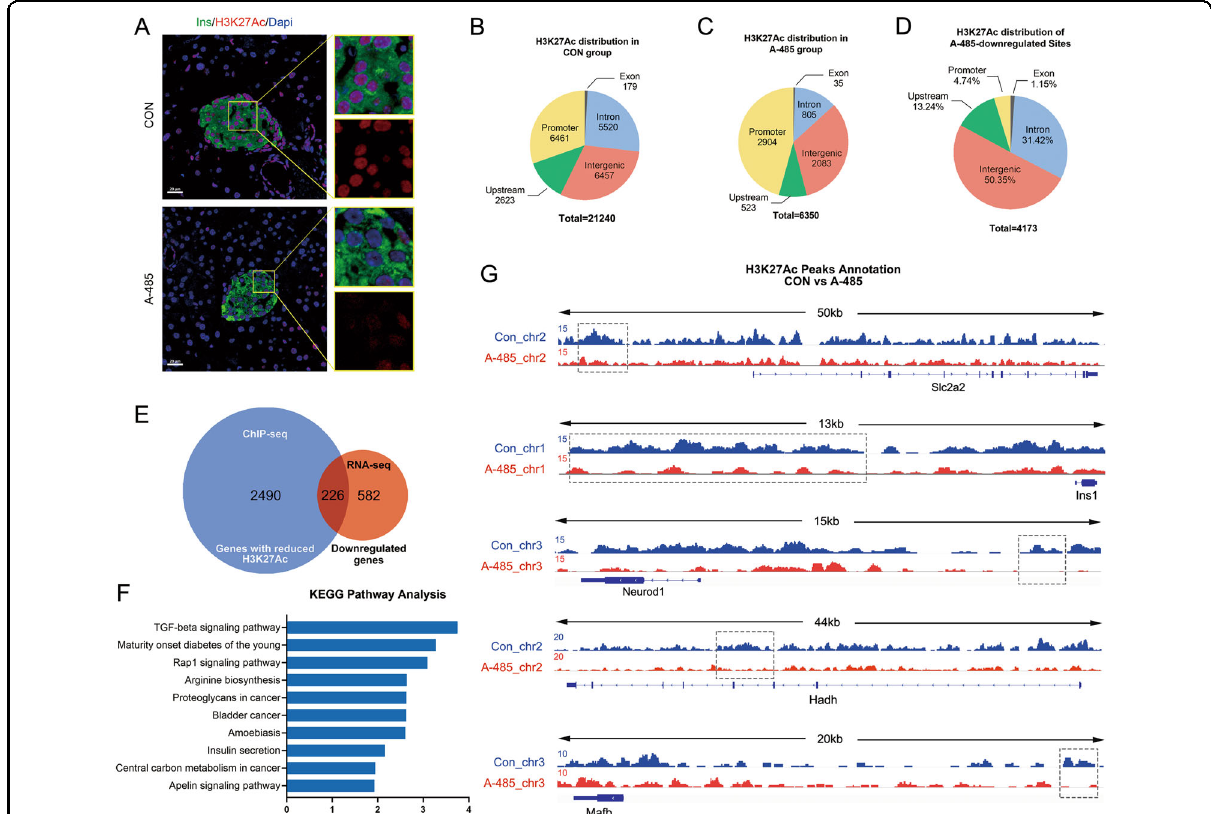
Fig. 5 Role of H3K27Ac in CBP/p300-mediated islet identity gene expressions. A Representative pancreatic sections co-immunostained for insulin (Ins, green), H3K27Ac (red), and DAPI (blue) from control and A-485-treated mice (scale bars, 20 μ m). B – C Genomic distribution of H3K27Ac peaks in control and A-485-treated rat islets. D Genomic distribution of downregulated H3K27Ac peaks between two groups (fold change ≥ 2.0, p value <0.001). E Overlap analysis of annotated genes with hypo-H3K27Ac and downregulated genes identi fi ed in RNA-seq. F KEGG pathway analysis of overlapping genes. G Visualization of H3K27ac levels in adjacent area of transcriptional regions. Chromosomal span and gene structure are shown, and the signi fi cantly downregulated peaks are highlighted with the gray dotted